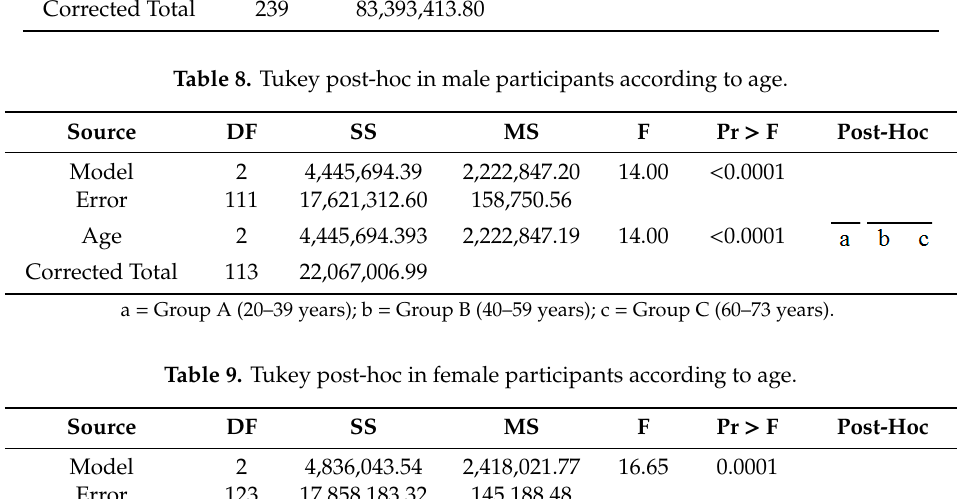
Table 5. Tukey post-hoc test in male participants according to age.